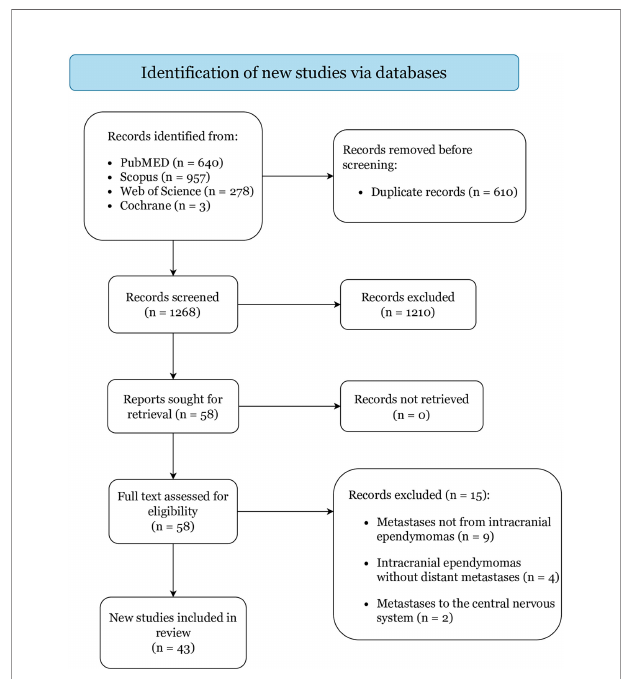
FIGURE 1 | PRISMA 2020 fl ow